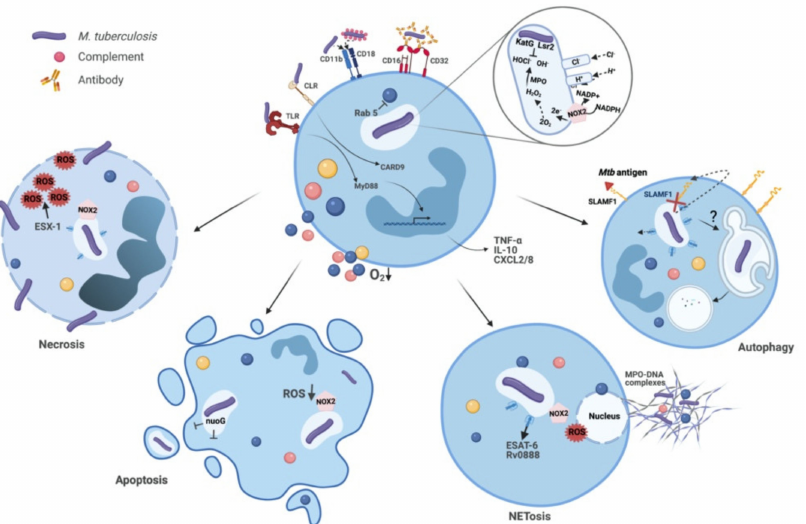
Figure 1. Phagocytosis of mycobacteria and neutrophil fate post-infection. Opsonic, i.e., Fc receptors (Fc γ RIII/Fc γ RII, CD16/CD32) and complement receptors (CR3, CD11b/CD18), and non-opsonic, i.e., C-type lectin receptors (CLR), receptors control the internalization of mycobacteria. Neutrophil activation, including the release of cytokines and chemokines as well as degranulation, is in addition triggered by Toll-like receptors (TLR) and modulated by hypoxia. Phagosomal recruitment of the nicotinamide adenine dinucleotide phosphate oxidase (NADPH oxidase, NOX2) and the production of reactive oxygen species (ROS) do not eliminate Mycobacterium tuberculosis ( Mtb ). Abundant ROS rather cause neutrophil necrosis and the formation of neutrophil extracellular traps (NETs), whereas mycobacterial factors restrict apoptosis and autophagy. Abbreviations: CARD9, caspase recruitment domain-containing protein 9; CD, cluster of differentiation; CXCL, (C-X-C motif) ligand; ESAT- 6, 6 kDa early secretory antigenic target; ESX-1, 6 kDa early secretory antigenic target secretion system 1; IL, interleukin; KatG, catalase-peroxidase; Lsr2, nucleoid-associated protein of Mtb ; MPO, myeloperoxidase; MyD88, myeloid differentiation primary response 88; nuoG, operon in Mtb ; O 2 , oxygen; SLAMF1, signaling lymphocytic activation molecule family member 1; TNF, tumor necrosis factor. Image created with BioRender.com